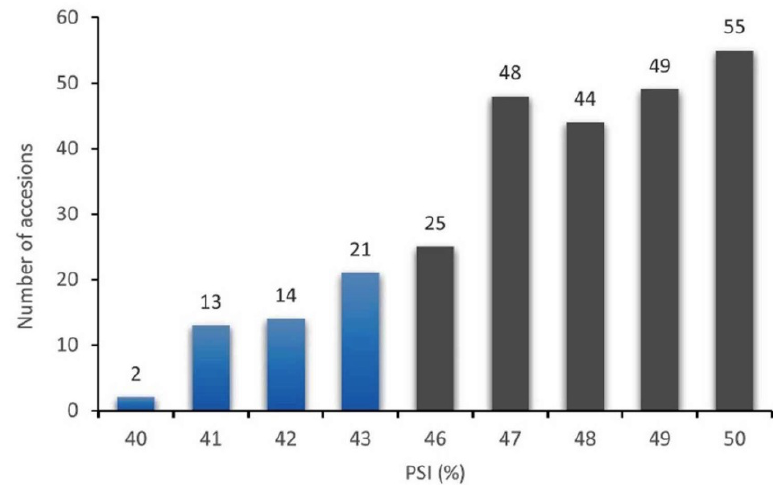
Figure 1. PSI frequency distribution of the accessions evaluated. Blue bars indicate hard grain accessions; grey bars correspond to semi-hard grain accessions.